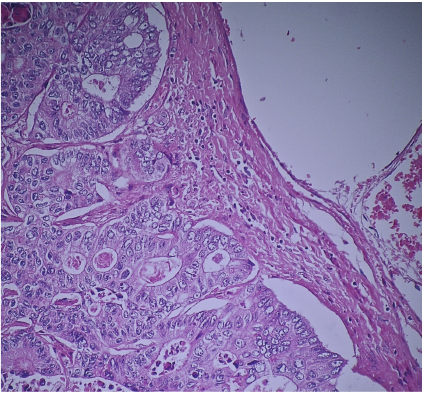
Figure 9: Microscopic examination of IVC at magnification × 10 with H&E stains. Moderately differentiated adenocarcinoma cells are noted to the left of the image, encroaching onto but not invading the endothelium of the